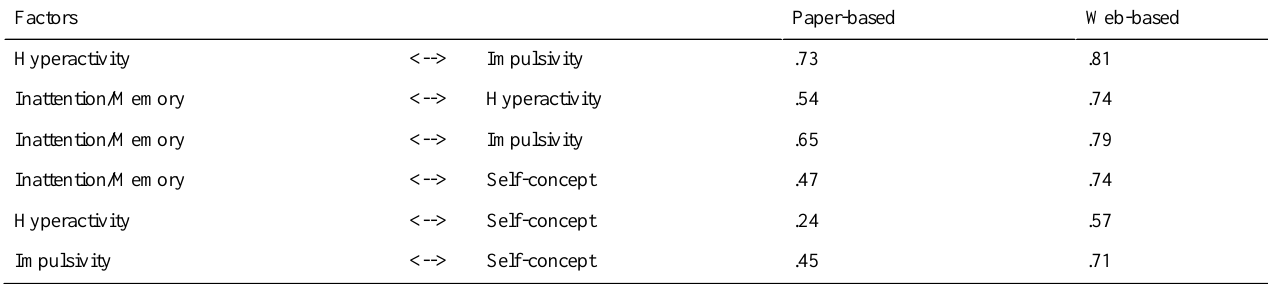
Table 3. Intercorrelations between the CAARS factors (latent constructs) in the paper-based and Web-based samples.